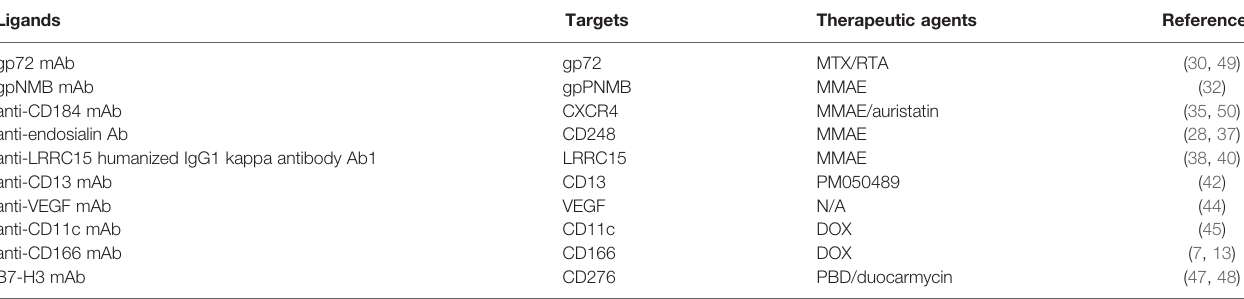
TABLE 2 | Targeted delivery based on antibody as ligands.